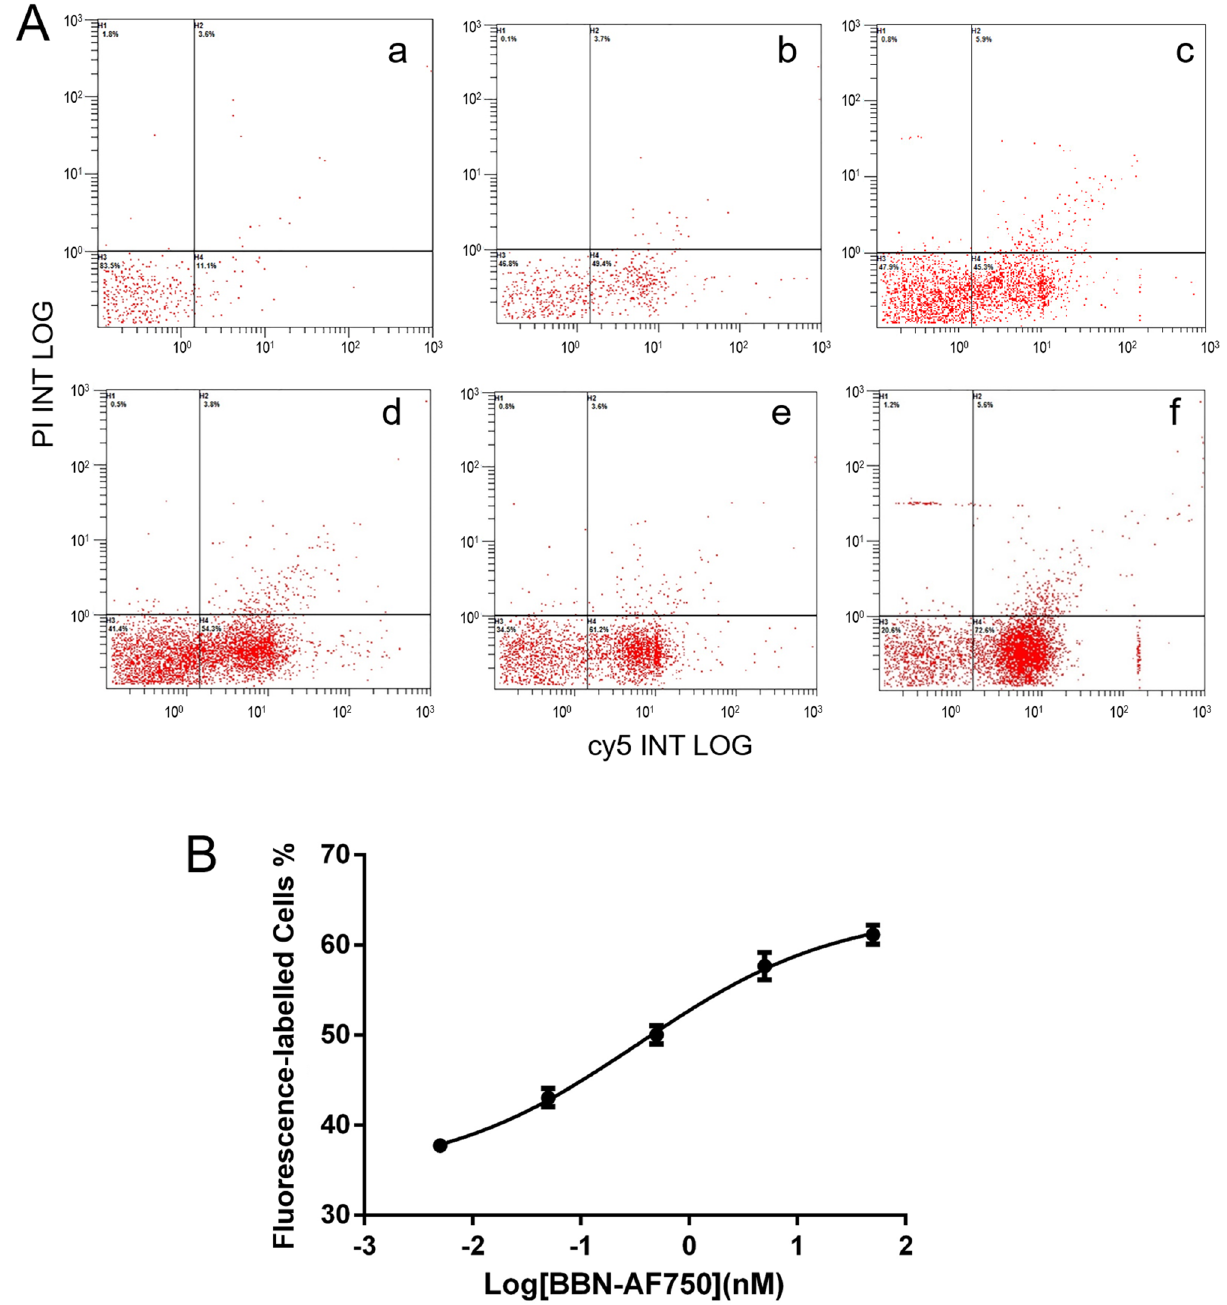
Figure 7. In vitro competitive GRPR binding assay in HSC-3 cells. ( A ) Histograms of fluorescent labelled HSC-3 cells at different concentrations of AF750-6Ahx-Sta-BBN (a–f: 0, 0.005, 0.05, 0.5, 5, 50 nM). ( B ) The EC50 of AF750-6Ahx-Sta-BBN was estimated as 0.47 ± 1.05 nM for HSC-3